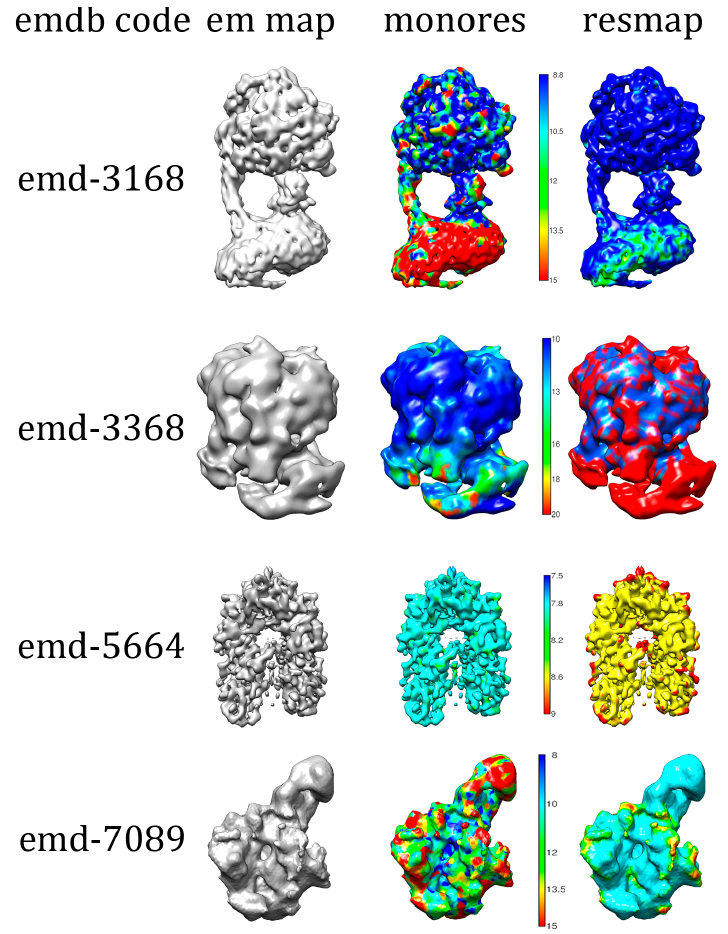
Figure 6. Examples of Electron Microscopy Data Bank (EMDB) structures and respective ResMap and MonoRes local resolution maps used to train the 3D U-Net model. Table 7. Input and label cube counts for processed